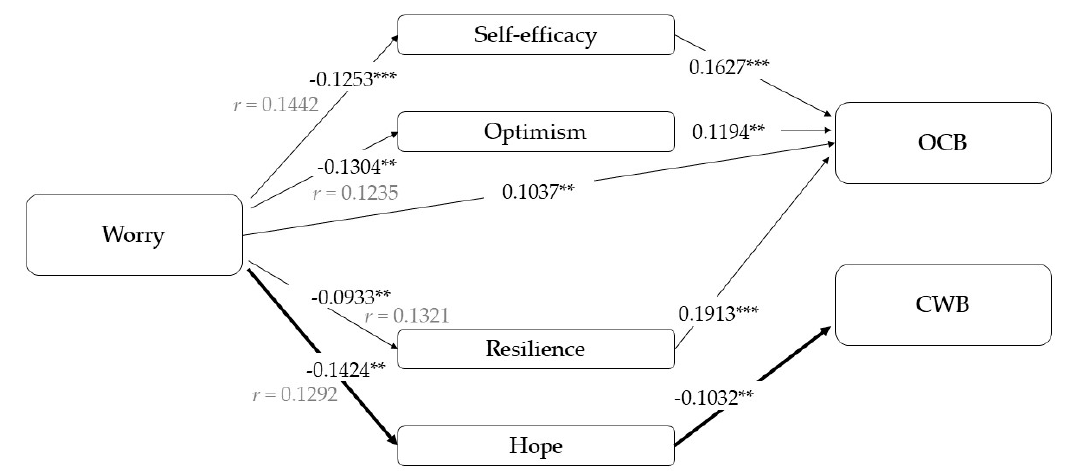
Figure 6. Results of the mediation models with worry as an independent variable. Note: [95% CI]; ** p < 0.01; *** p < 0.001.